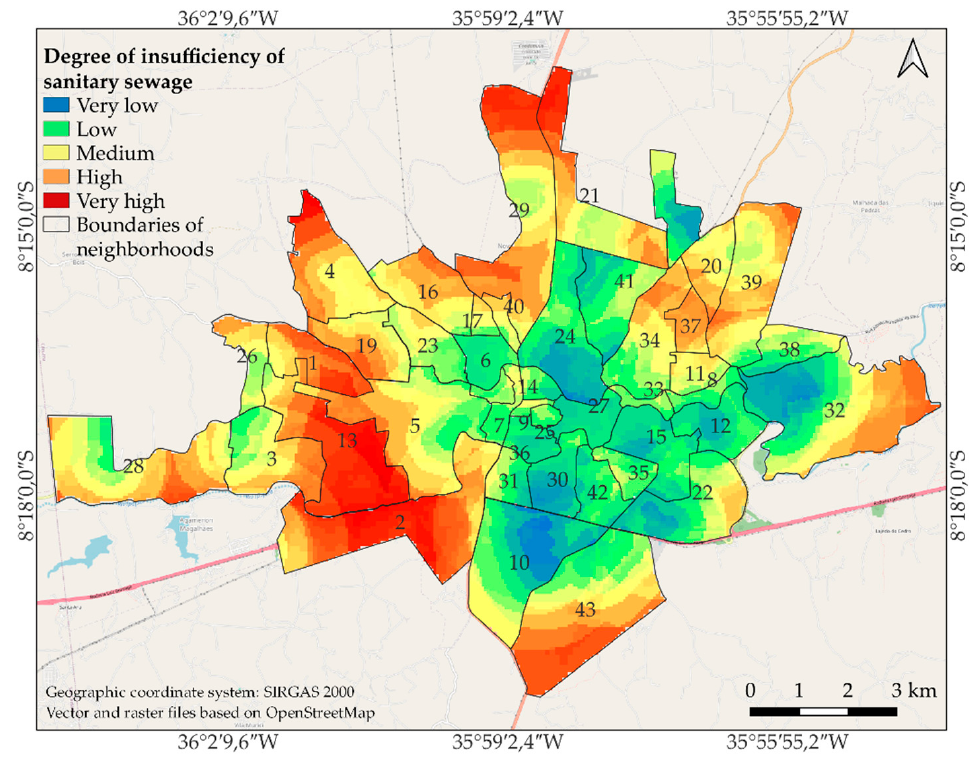
Figure 7. Mapping of the degree of insufficiency of the sanitary sewage network for the city of Caruaru, Pernambuco.